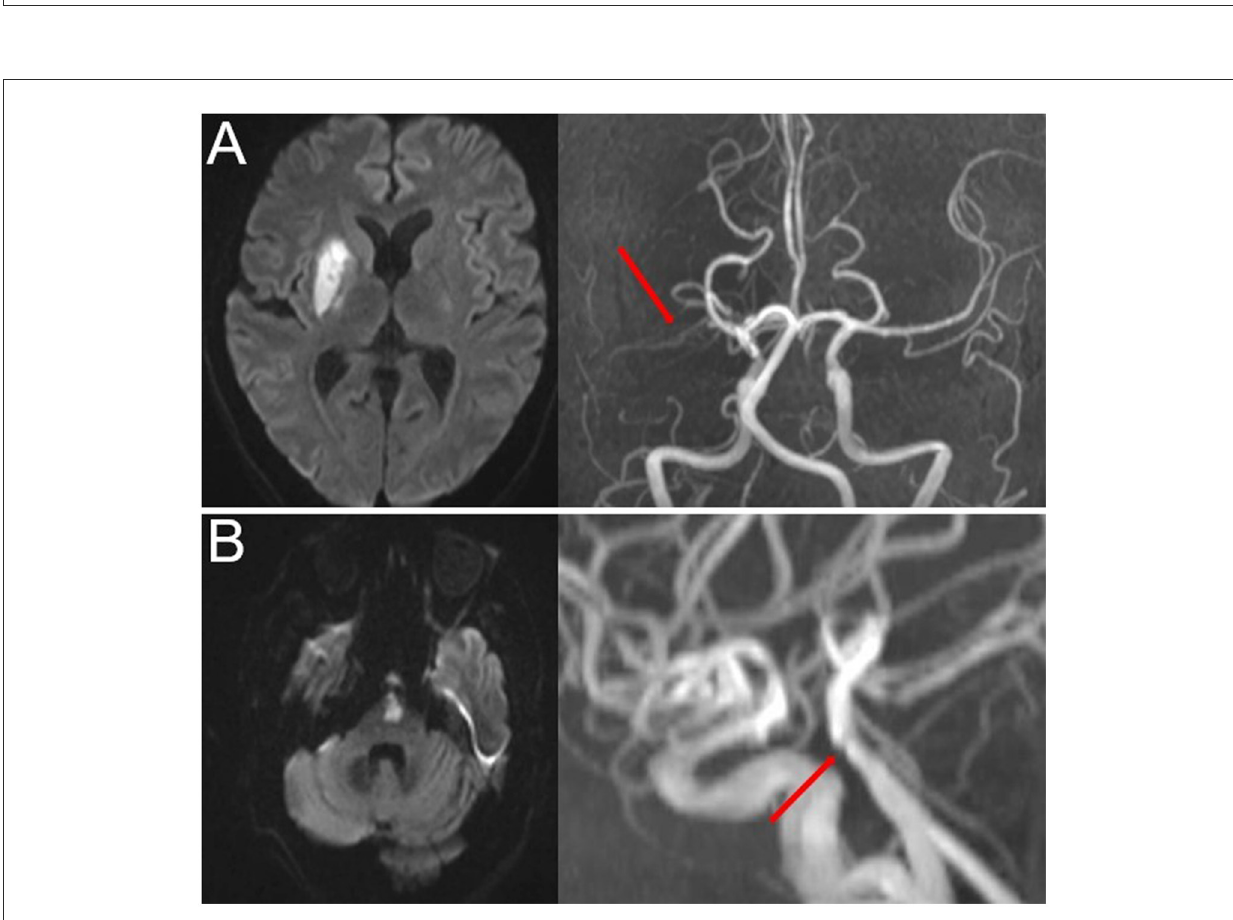
FIGURE2 Representative cases of PAD. (A) Anterior SSI with PAD (red arrow) and (B) posterior SSI with PAD (red arrow). SSI, single subcortical infarction; PAD, parental arterial